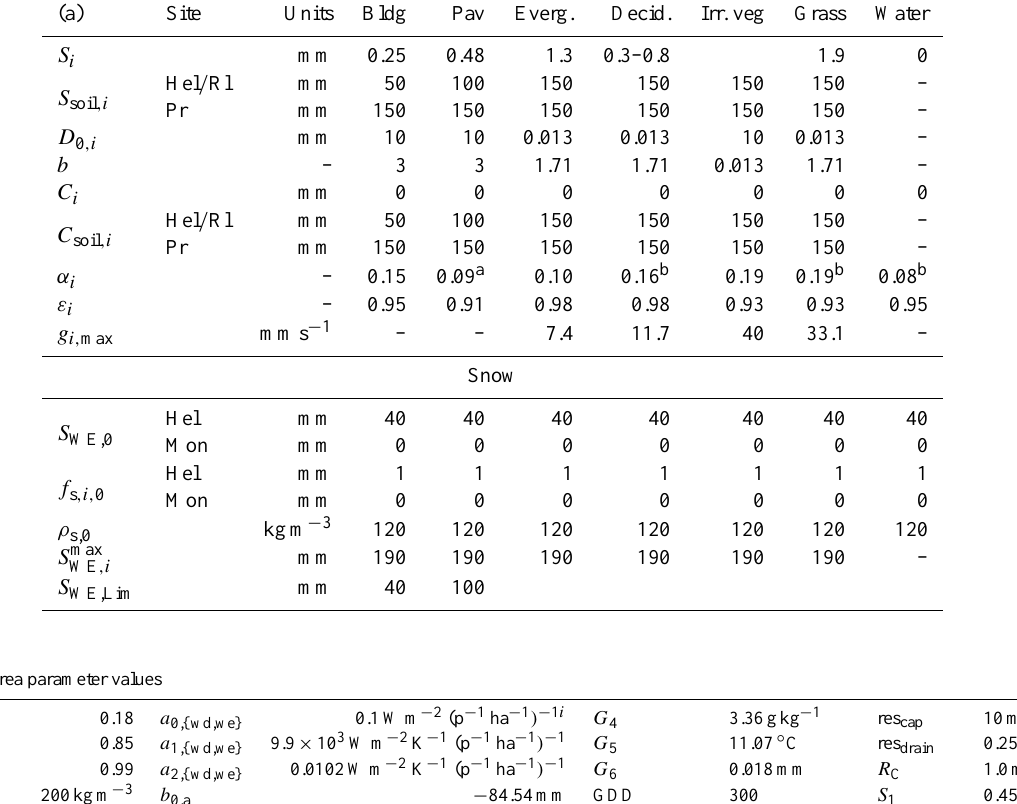
Table 4. Parameters used in SUEWS for surfaces that are buildings (bldg), pavement (pav), evergreen vegetation (everg), deciduous vegeta- tion (decid), grass and water. If the vegetation is irrigated, different values for describing the canopy are used. Sources of the values are as in Järvi et al. (2011) unless indicated otherwise below. Where different values are used for the different sites, this is indicated for Helsinki (Hel), and for the two sites in Montreal (Rl and Pr). Variable notation is given in Appendix